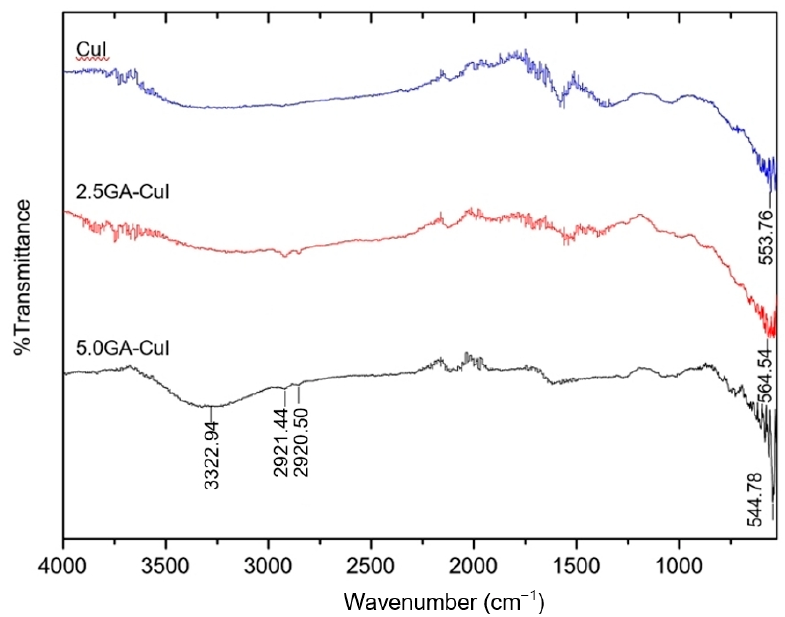
Figure 4. FTIR spectra of green synthesized CuI NPs using different gallic acid (GA) concentrations of 0, 2.5 and 5.0 mM.